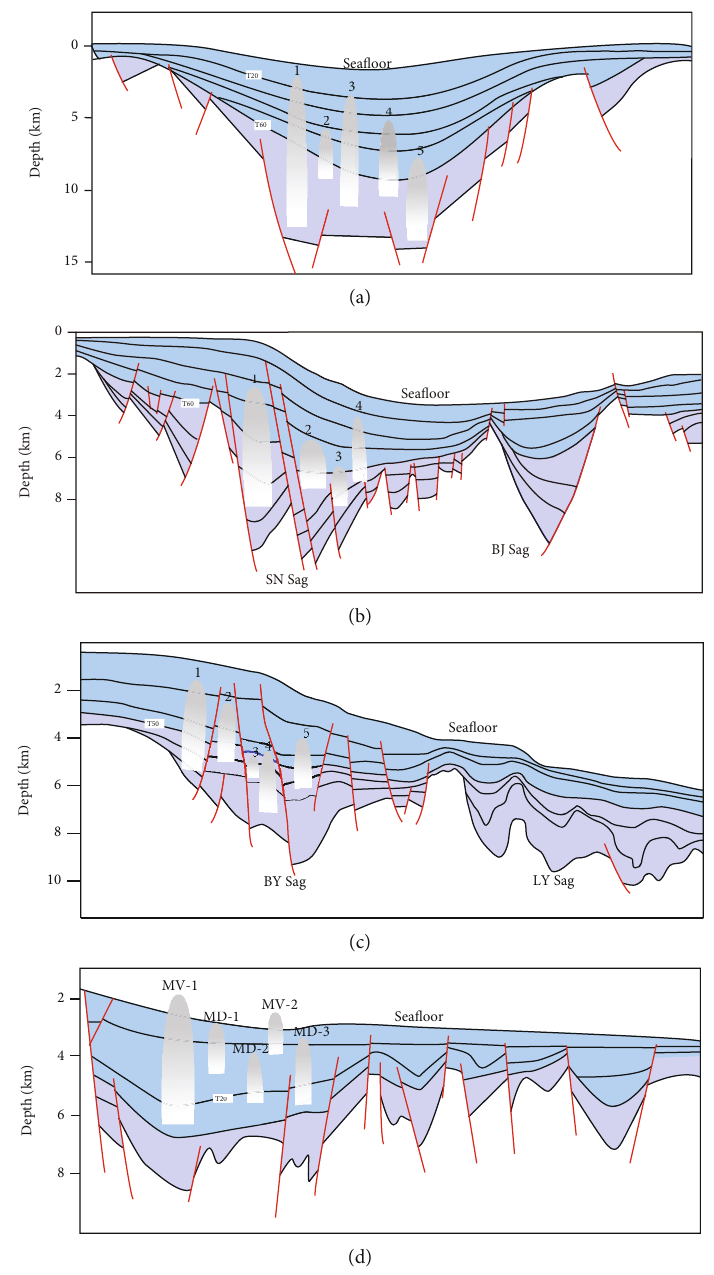
Figure 9: (a) Developmental pattern of mud diapirs in Yinggehai Basin. Mud diapirs developed based on the sediments from the Neogene Sanya Formation to Yinggehai Formation. Mud diapirs vertically pierce through to the Quaternary strata. The grey-purple part indicates the Paleogene stratum. The source of MD-1 and MD-5 is deeper than other mud diapirs, and MD-1 pierces the shallower stratum; the sources of MD-2, MD-3, and MD-4 are shallow, and they pierce through strata at di ff erent depths. (b) Developmental pattern of mud diapirs in Qiongdongnan Basin. Mud diapirs are derived from Paleogene (Eocene-Oligocene) shale, which penetrates the Neogene strata vertically. The grey-purple part indicates the Paleogene stratum. The source of MD-1 and MD-3 is deeper than other mud diapirs, and MD 1 pierces the shallower stratum; the sources of MD 2 and MD-4 are shallow, and they pierce through strata at di ff erent depths. (c) Developmental pattern of mud diapirs in Baiyun sag of Pearl River Mouth Basin. The source of the diapir material is Paleogene (Eocene- Oligocene) shale, and diapirs pierce the Neogene strata vertically. The grey-purple part indicates the formation below the T50 interface. The source of MD-1 and MD-4 is deeper than other mud diapirs, and MD-1 pierces the shallower stratum; the sources of MD-2, MD-3, and MD-5 are shallow, and they pierce through strata at di ff erent depths. (d) Developmental pattern of mud volcanoes and mud diapirs in Southwest Taiwan Basin. The source of mud volcanoes and mud diapirs is Neogene (Miocene and Pliocene) shale, and the fl uid penetrates through the Quaternary strata or the sea fl oor. The grey-purple part indicates the Paleogene stratum. MV-1 and MV-2 represent mud volcanoes of di ff erent scales; MD-1 indicates the shallow diapir of the source, and the vertical piercing is close to the seabed; MD-2 and MD-3 have deeper sources and pierce through di ff erent